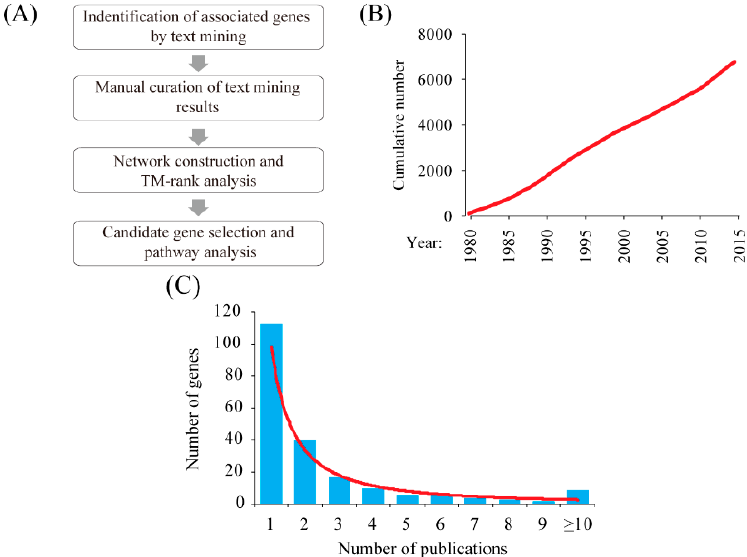
Figure 1. Systematic identification of susceptibility genes for ectopic pregnancy. ( A ) Overview of the experimental design; ( B ) Cumulative number of publications related to ectopic pregnancy by year (from 1980 to 2015); ( C ) Distribution of the number of publications per gene.